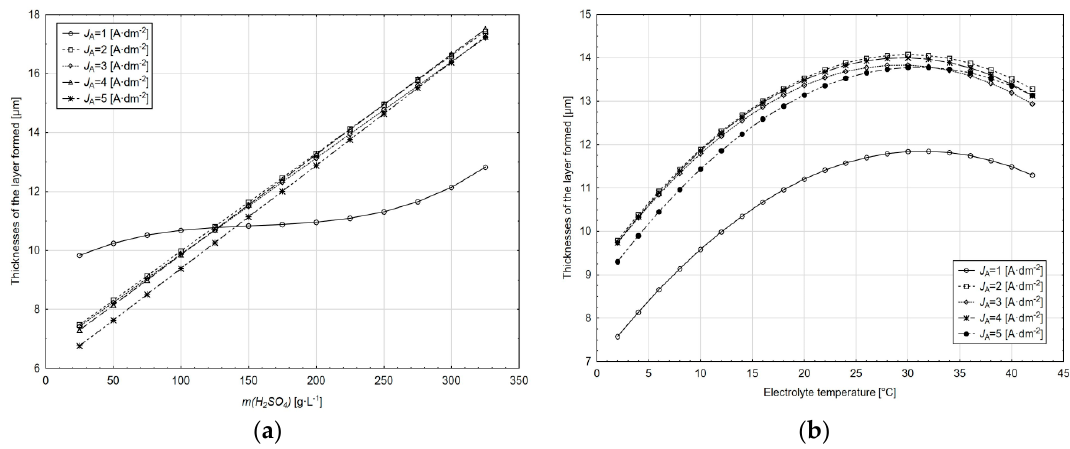
Figure 11. ( a ) Effect of the sulphuric acid amount for J A = 1 to 5 A·dm − 2 at the electrolyte temperature of 18 °C and the anodic oxidation time of 35 min; ( b ) Effect of the electrolyte temperature for J A = 1 to 5 A·dm − 2 with of 200 g·L − 1 of sulphuric acid and the anodic oxidation time of 35 min.